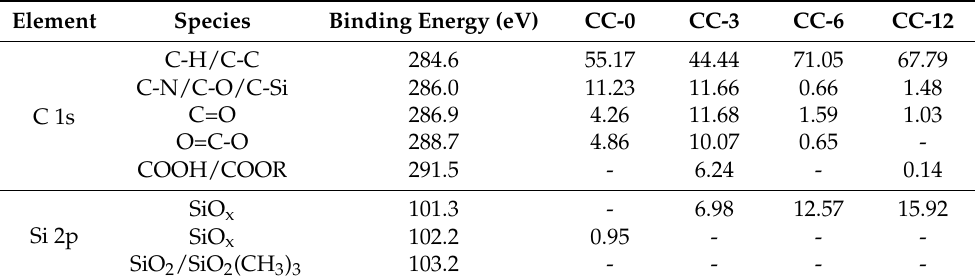
Table 3. Atomic percentages (at.%) of XPS-identified chemical species at the C 1s and Si 2p peaks of untreated and plasma-coated leather